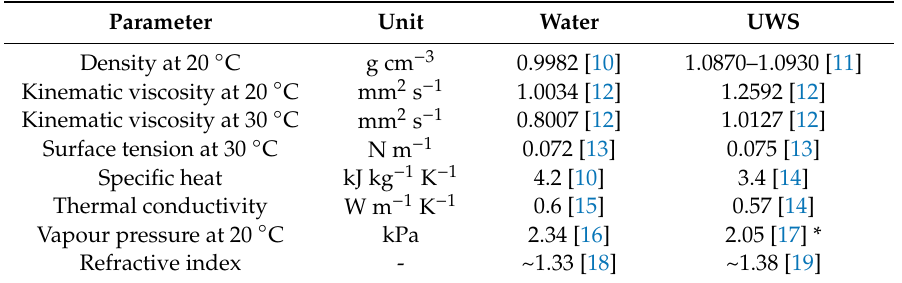
Table 1. Physical properties of water and urea–water solution (UWS) (32.5% urea mass fraction).